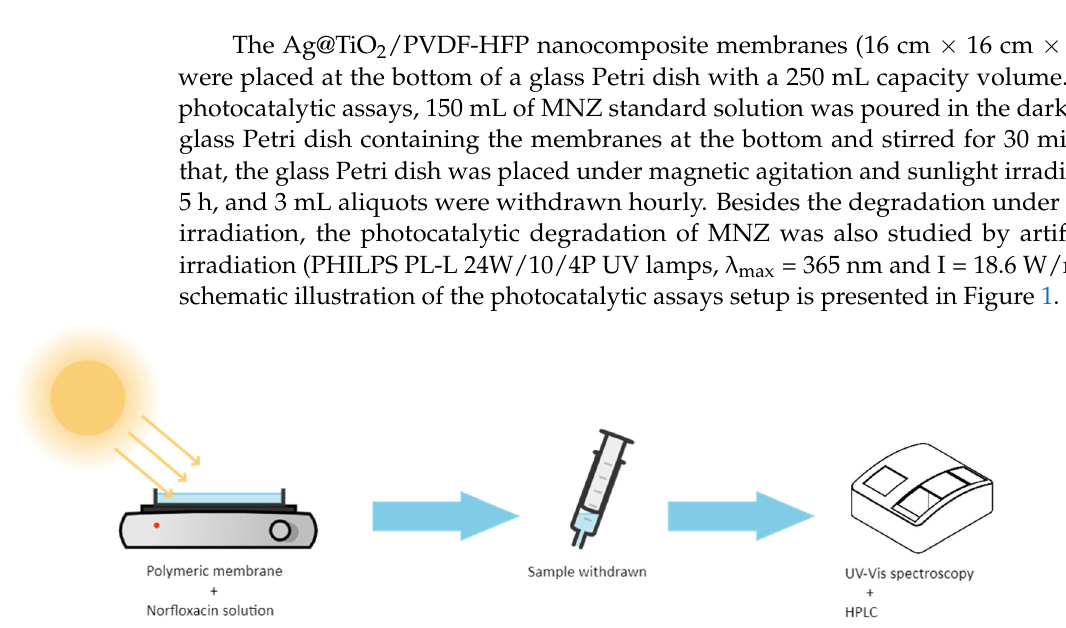
Figure 1. Schematic illustration of the photocatalytic degradation setup and monitoring assays per-